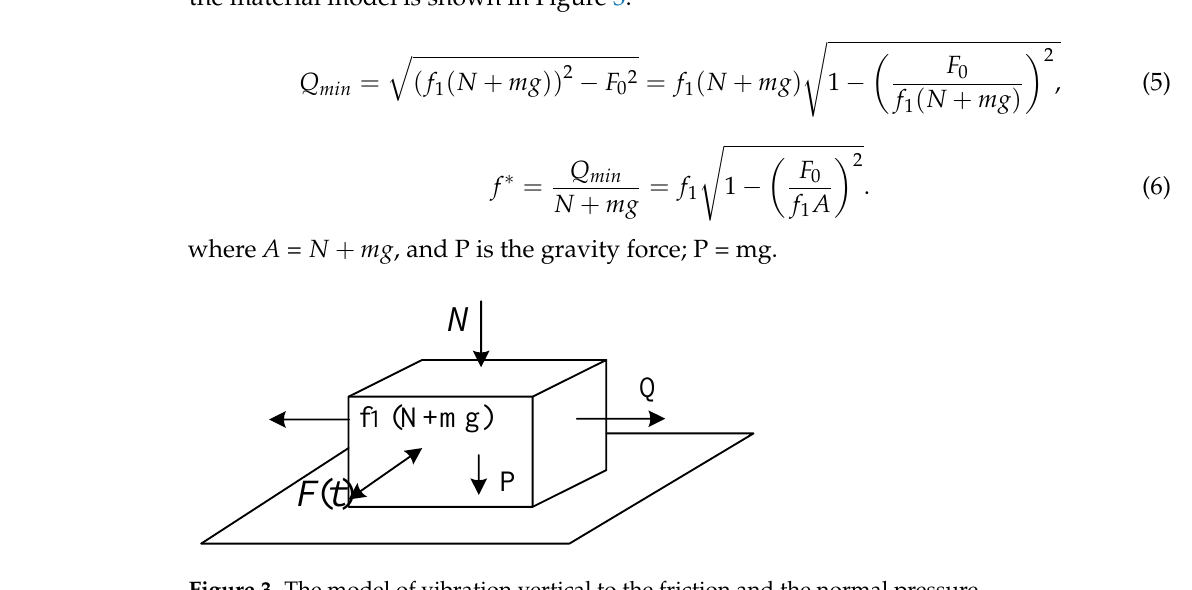
Figure 4. Model of the vibratory material under arbitrary vibration.